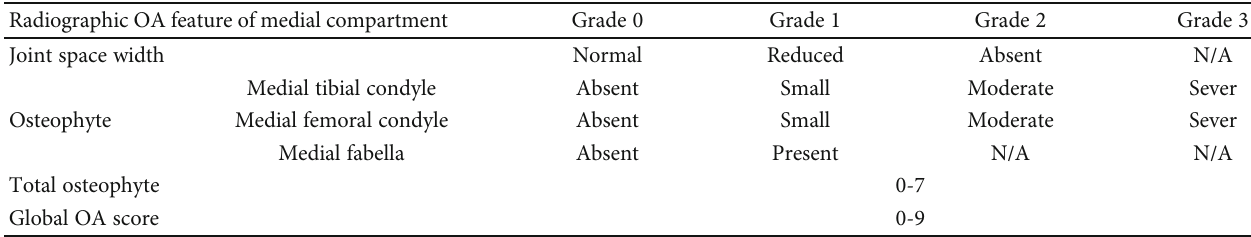
Table 1: Radiological grading for knee osteoarthritis (OA) in rat models.